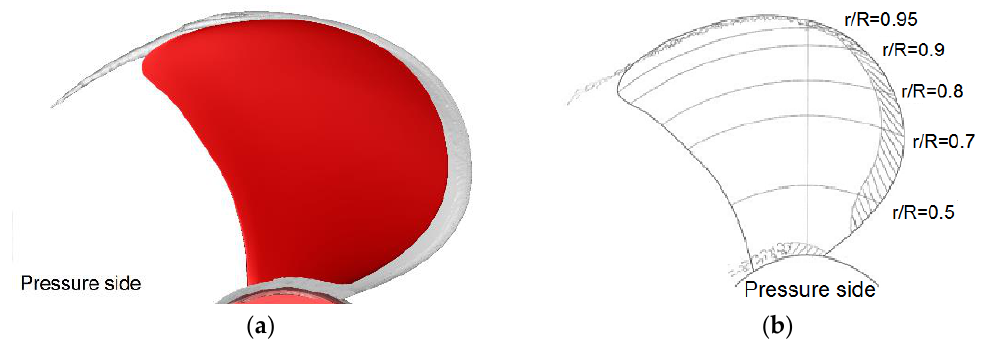
Figure 20. Comparison between the computed cavitation extension for 𝜎 𝑛 = 2.000 and the experimental cavitation sketch [46] reproduced with the permission of L. Lubke (SVA). ( a